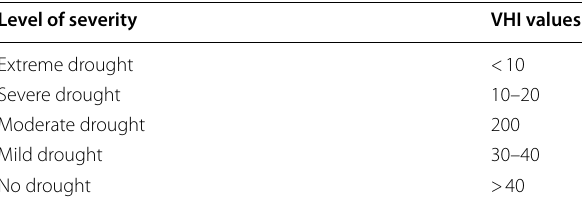
Table 1 Agricultural drought severity by VHI (Source: Kogan 2001) Level of severity Extreme